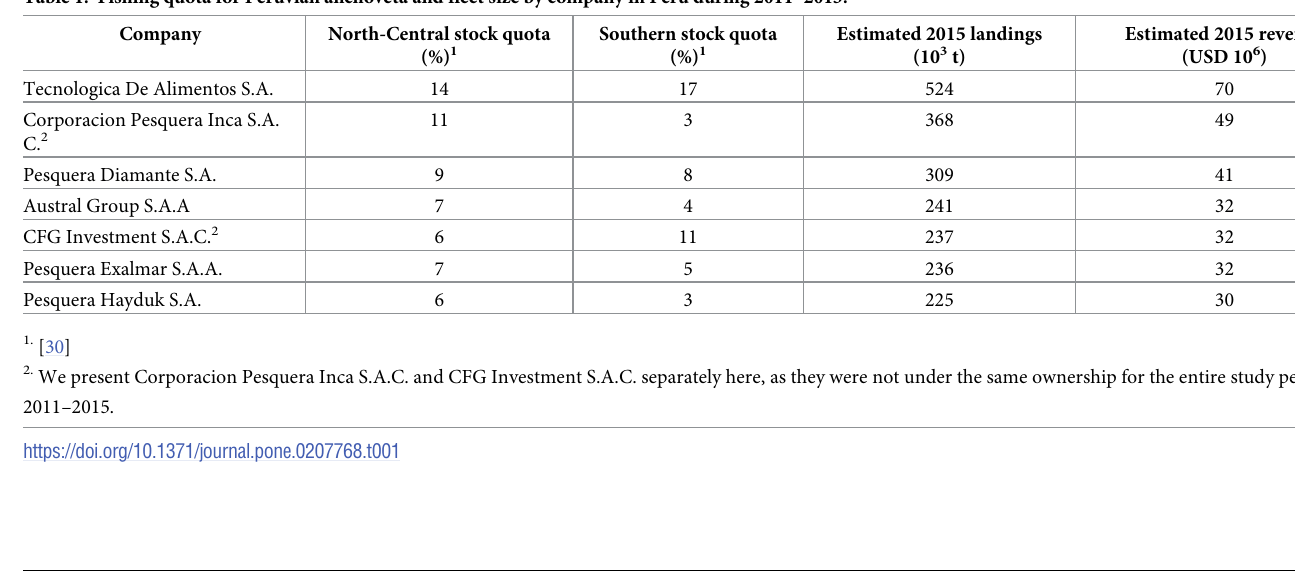
Table 1. Fishing quota for Peruvian anchoveta and fleet size by company in Peru during